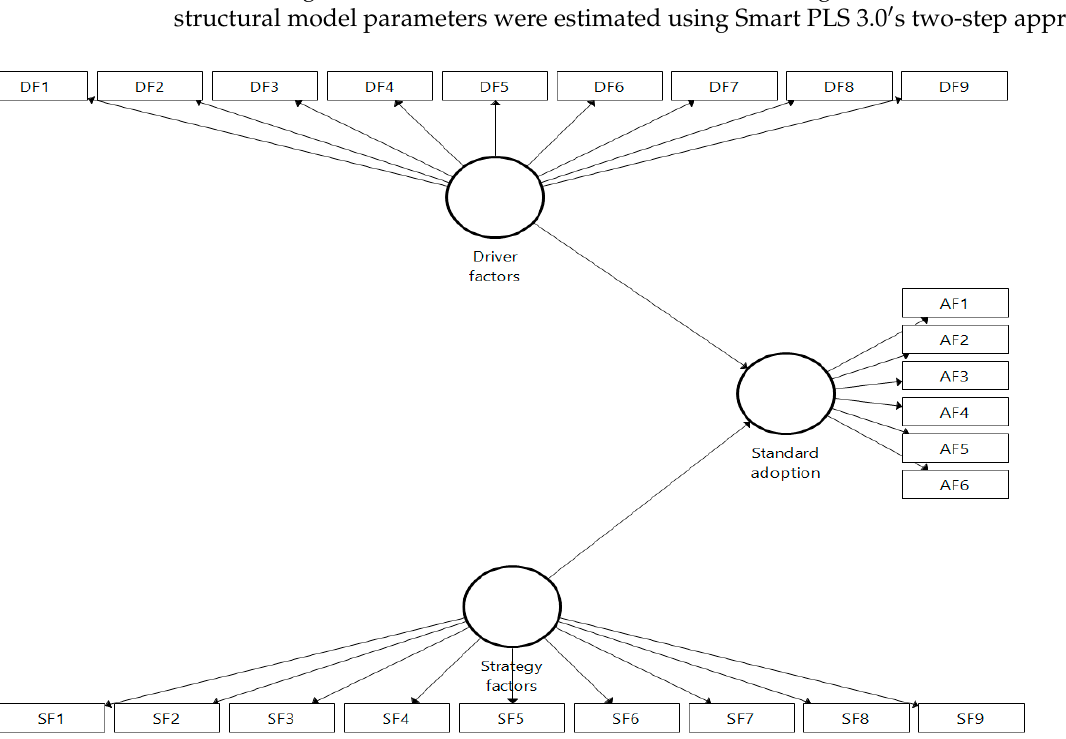
Figure 3. Driver and strategy factors’ in fl uence on standard adoption relationship model using the PLS-SEM methodology. Note: DF—driver factor; SF—strategy factor; AF—adoption factor. PLS-SEM methodology. Note: DF—driver factor; SF—strategy factor; AF—adoption